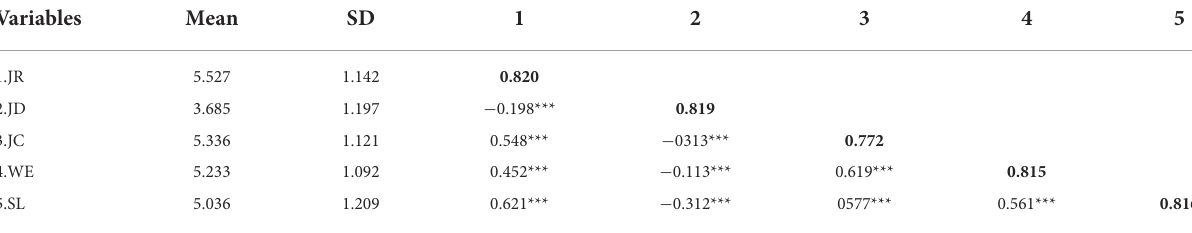
TABLE 3 Descriptive statistical analysis results.